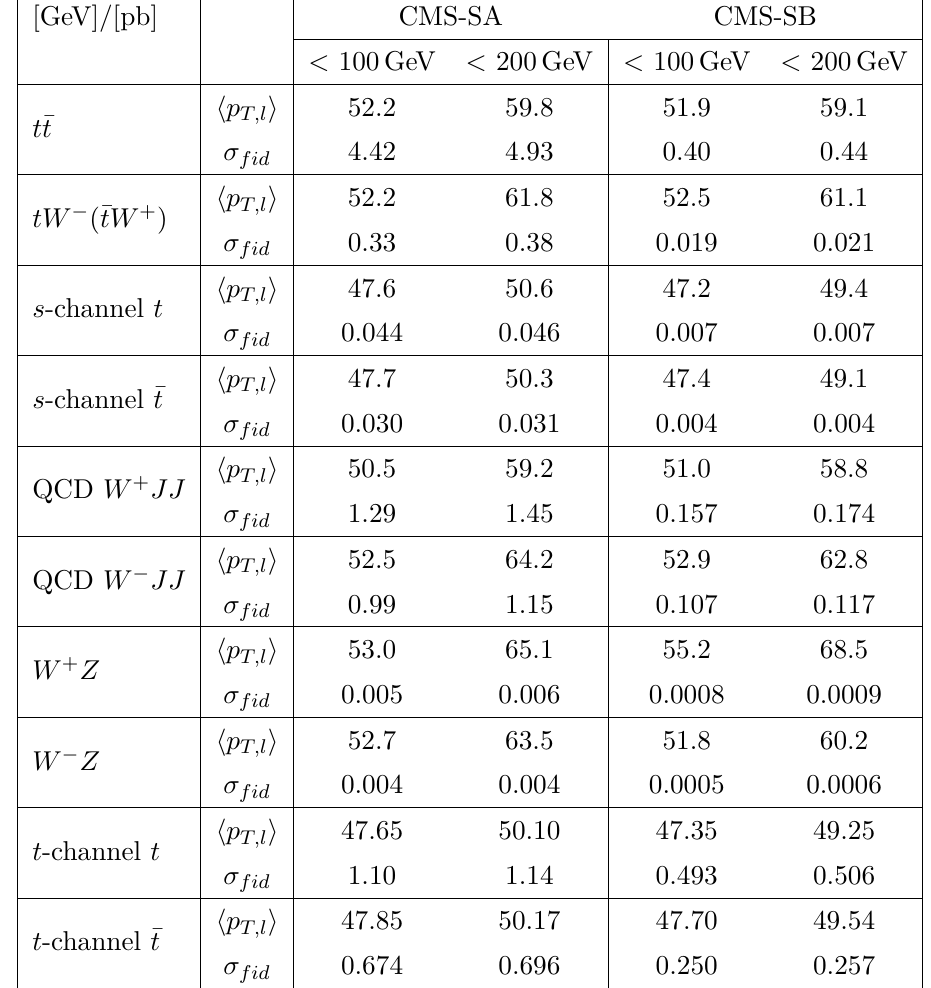
Table 9 . Average transverse momentum of the charged lepton and fiducial cross section within the two fiducial regions, for various background processes to t -channel top quark and anti-quark production. The top-quark pair production or top-quark associated production with W boson contribute equally to the two charge conjugate final